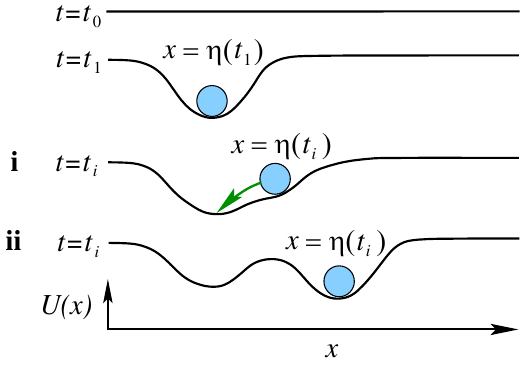
Figure 2. Idea of a plastic energy landscape. Illustration of the idea of the plastic energy landscape by analogy with memory foam. For a one-dimensional “foam” stretched in x direction, assume that initially it is flat and described as = U x ( , 0) 0 (see t = t 0 ). If the quicksilver drop lands onto the “foam” at position η = x , the landscape is deformed: a dent appears, which is the deepest exactly at η = x , and gets shallower at larger distances from η (see t = t 1 ). Thus the “foam” will learn about the occurrence of the drop and of its position. For more detail see